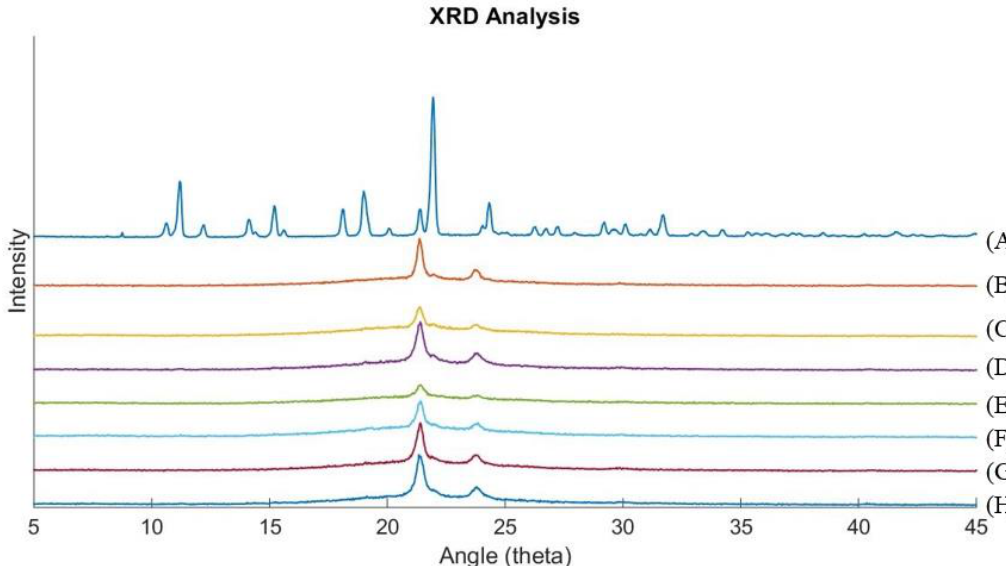
Figure 4. XRD results for imiquimod only ( A ), PCL only ( B ) and samples 1A, 1B, 2A, 2B, 3A, 3B (C to H respectively). The fiber samples only exhibit peaks for PCL and do not